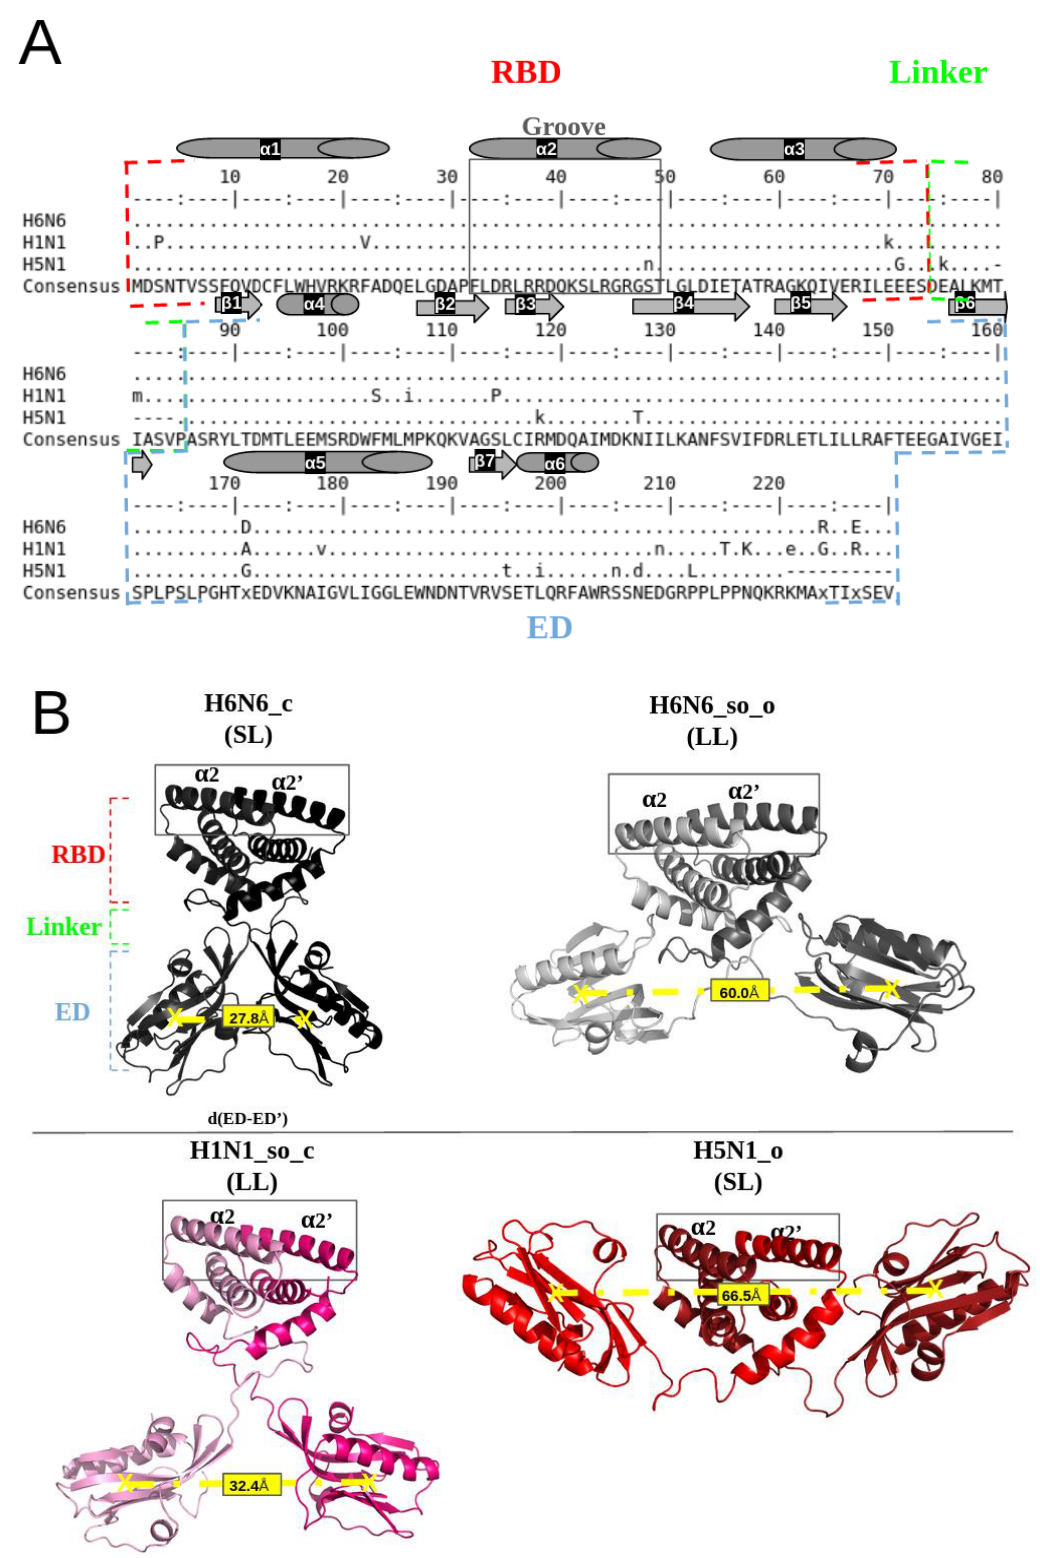
Figure 1. Illustration of the NS1 sequence conservation and the structural polymorphism of the NS1 protein: ( A ) Alignment of H6N6, H1N1 and H5N1 sequences extracted from the UniProt database (accession number: P03496, A5A5U1, Q20NS3 respectively) [25] using the “showalign” tool of software suite EMBOSS [24], showing conservation of the RBD region and particularly the “RBD-groove”, where the sequence is boxed in full gray lines. The RBD, ED and linker (long (LL) or short